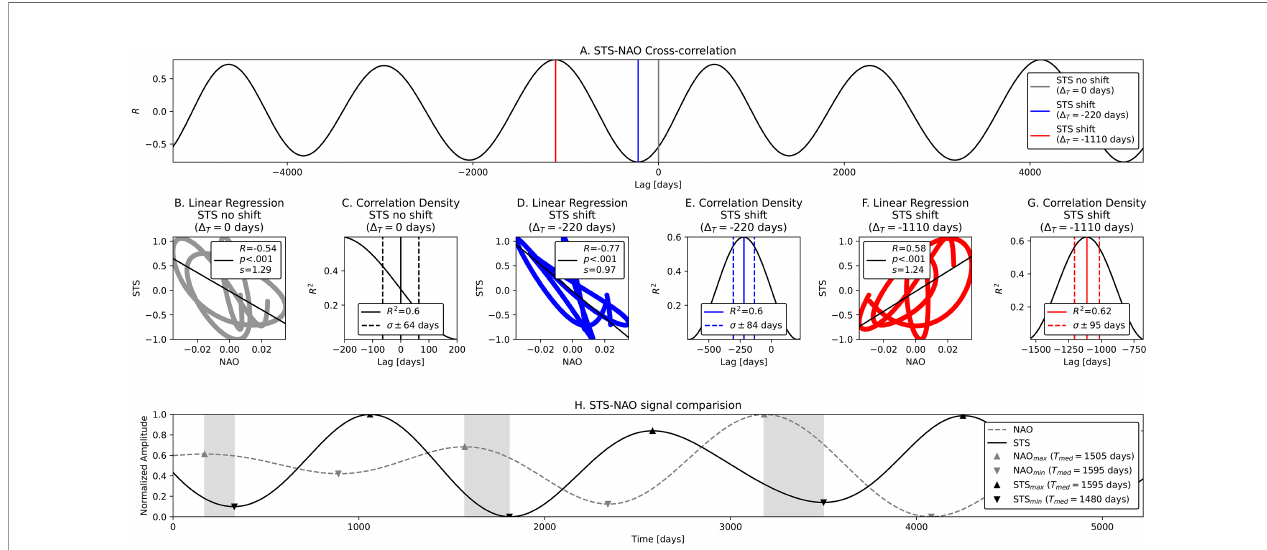
FIGURE 6 | STS-NAO Cross-correlation and linear regression of El Niño modes – T nino ~ 1700 days ~ 4.7 years . From top to bottom, left to right: (A) Correlation coef fi cients R for default STS (no shift) and shifted STS signals; (B – G) Linear regression results including coef fi cients of determination ( R 2 ) and error in days within 1 s ; and (H) Positions of NAO peaks and STS troughs. Both El Niño modes are